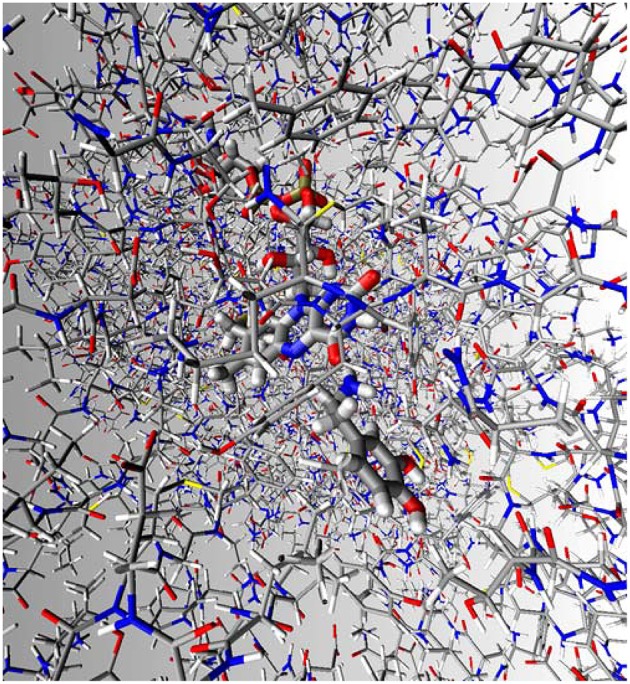
Structure of the MAO B active site with the reactive neutral dopamine. The FAD prosthetic group is shown in orange, dopamine in light blue, and Lys296 in violet.